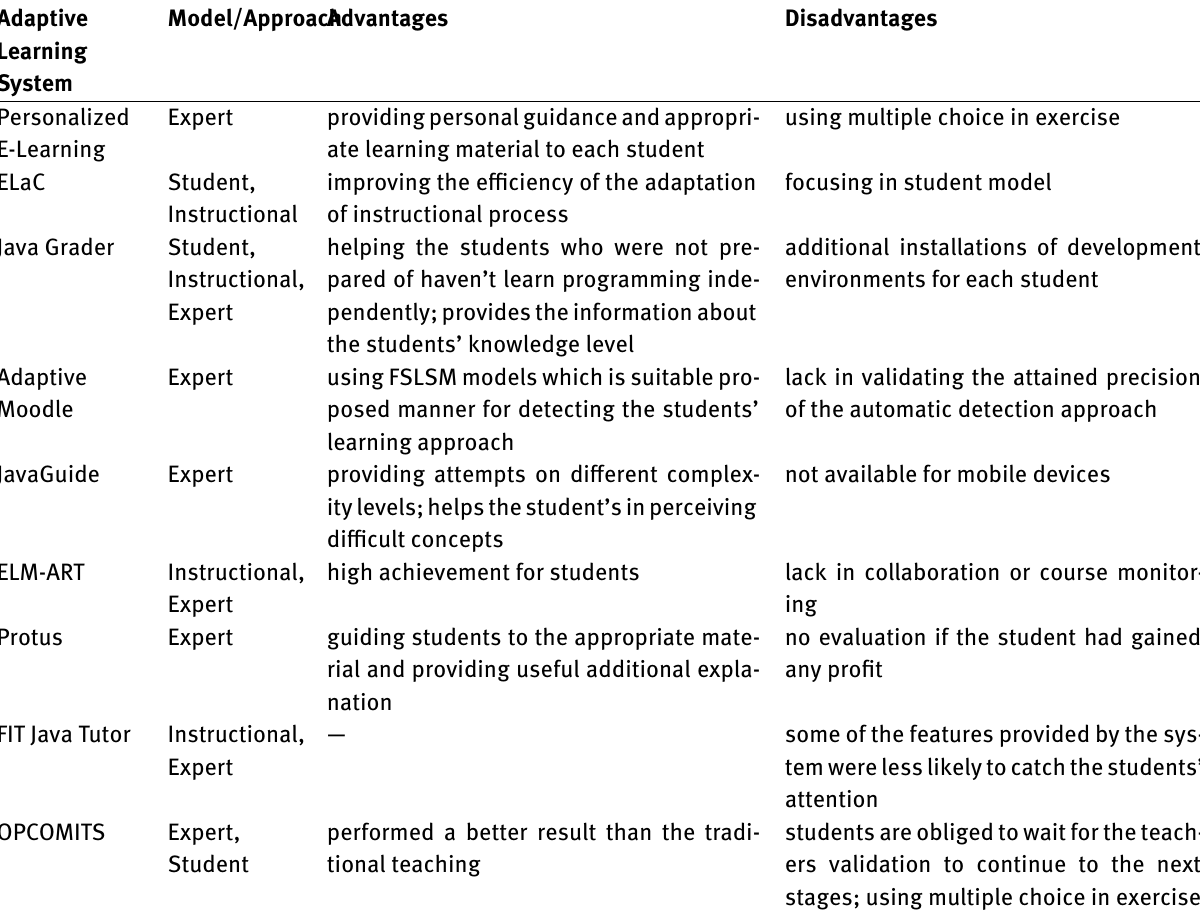
Table 3: Model used, advantages, and disadvantages of adaptive learning system